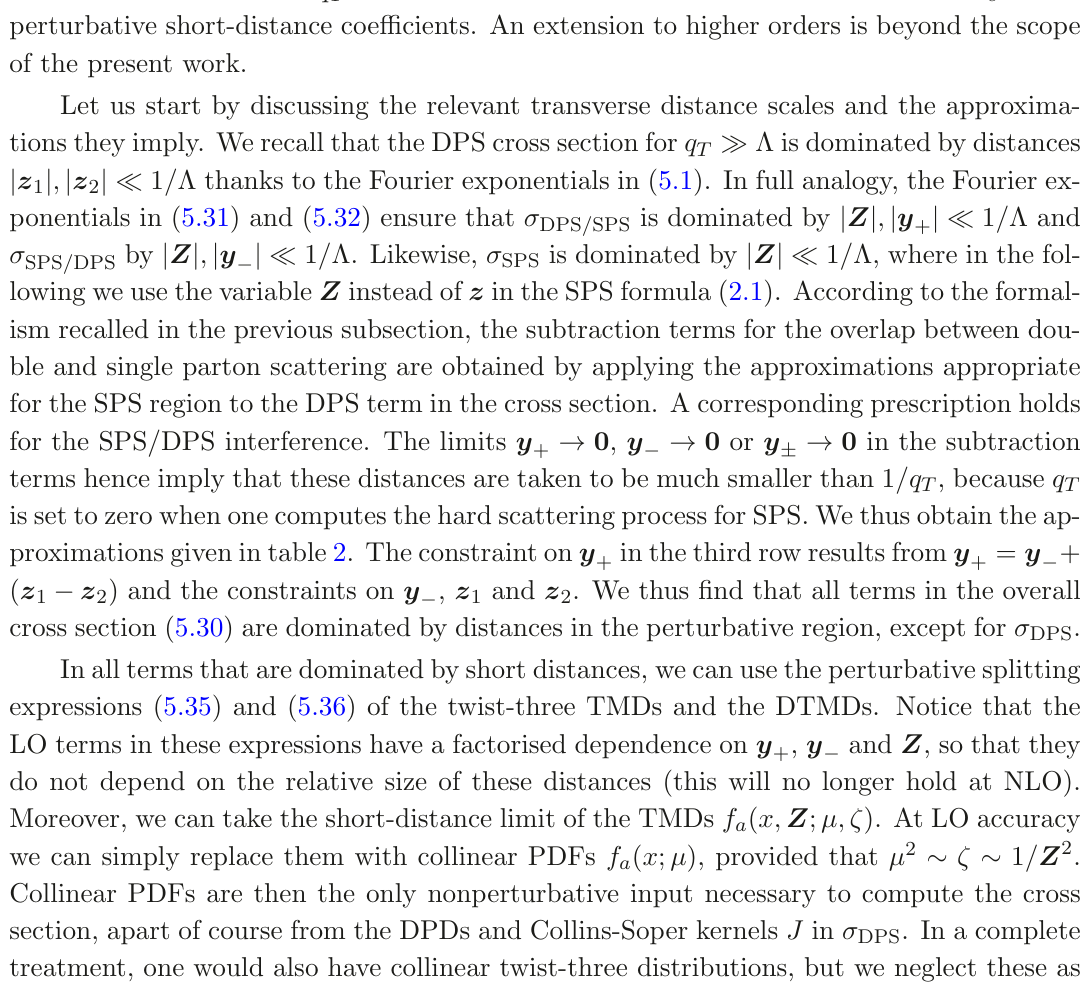
Table 2. Conditions on y Analogous relations hold for σ Z 1 / | | ≪